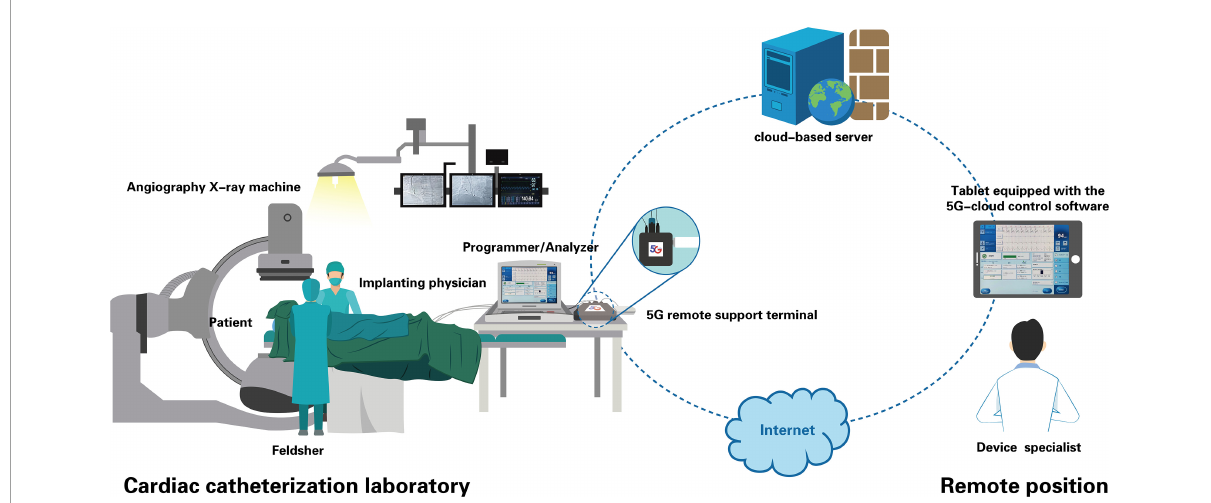
FIGURE1 Schematic representation of real-time remote testing and programming of cardiac implantable electronic devices through the 5G-CTP system. This 5G-CTP system is comprised of a 5G remote support terminal, a tablet equipped with the 5G-cloud control software, and a remote service system implemented on a cloud-based server. Prior to device implantation, a feldsher connected externally the 5G remote support terminal to the bedside programmer in the CCL. When confirming the communication is stable, the feldsher got contact with the device specialist. The device specialist logged into the 5G cloud control software subsequently to establish remote connection with the 5G remote support terminal and the programmer. Then he had the complete control of the programmer, and was able to conduct lead parameter testing and programing of implanted device remotely during the implantation procedure to aid implanting physicians in the selection of optimal lead placement. When implantation was complete, final programming parameters were also remotely completed.